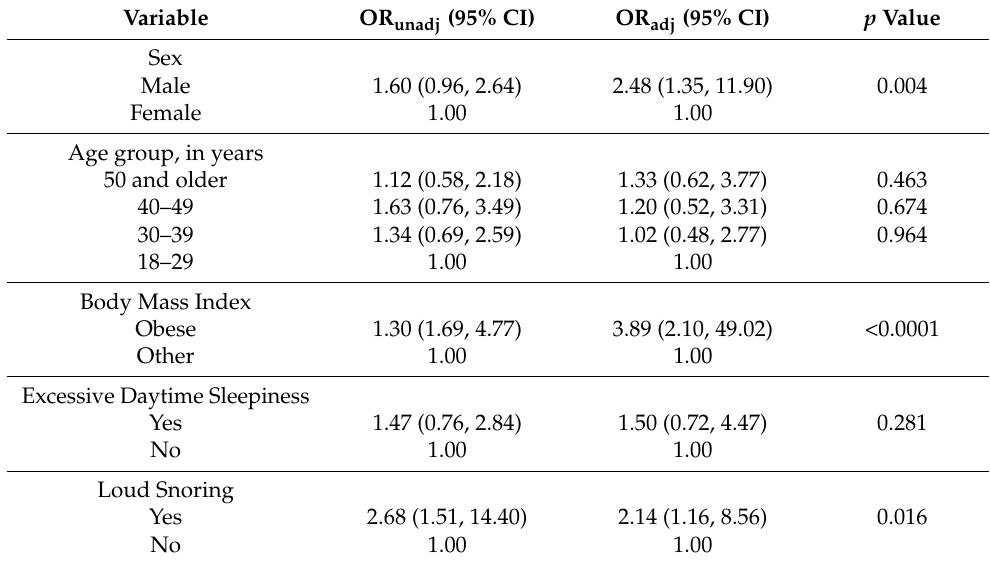
Table 2. Ordinal Regression * analysis of OSA and selected risk factors (n =